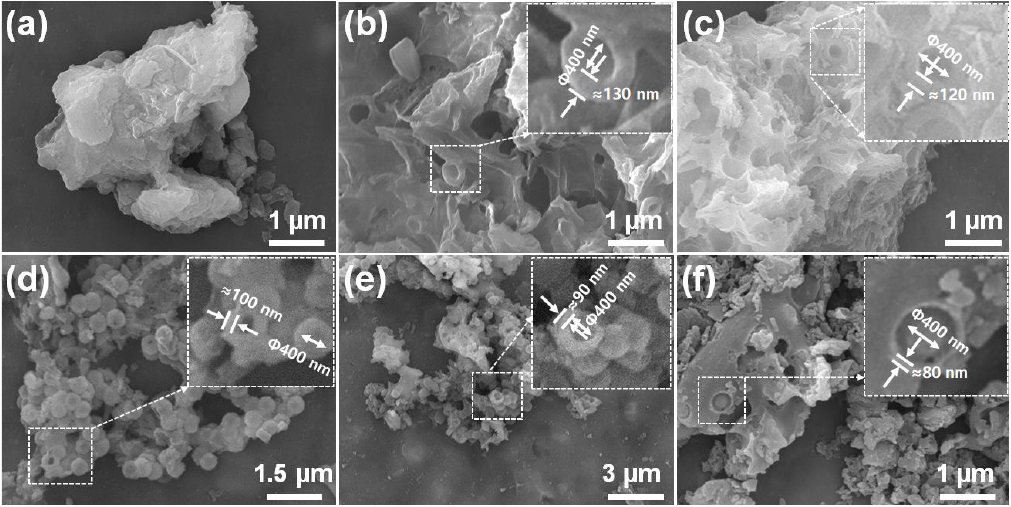
Figure 2. SEM of BSPI ( a ) and HSPI-1 to HSPI-5 ( b – f ) with different thicknesses.